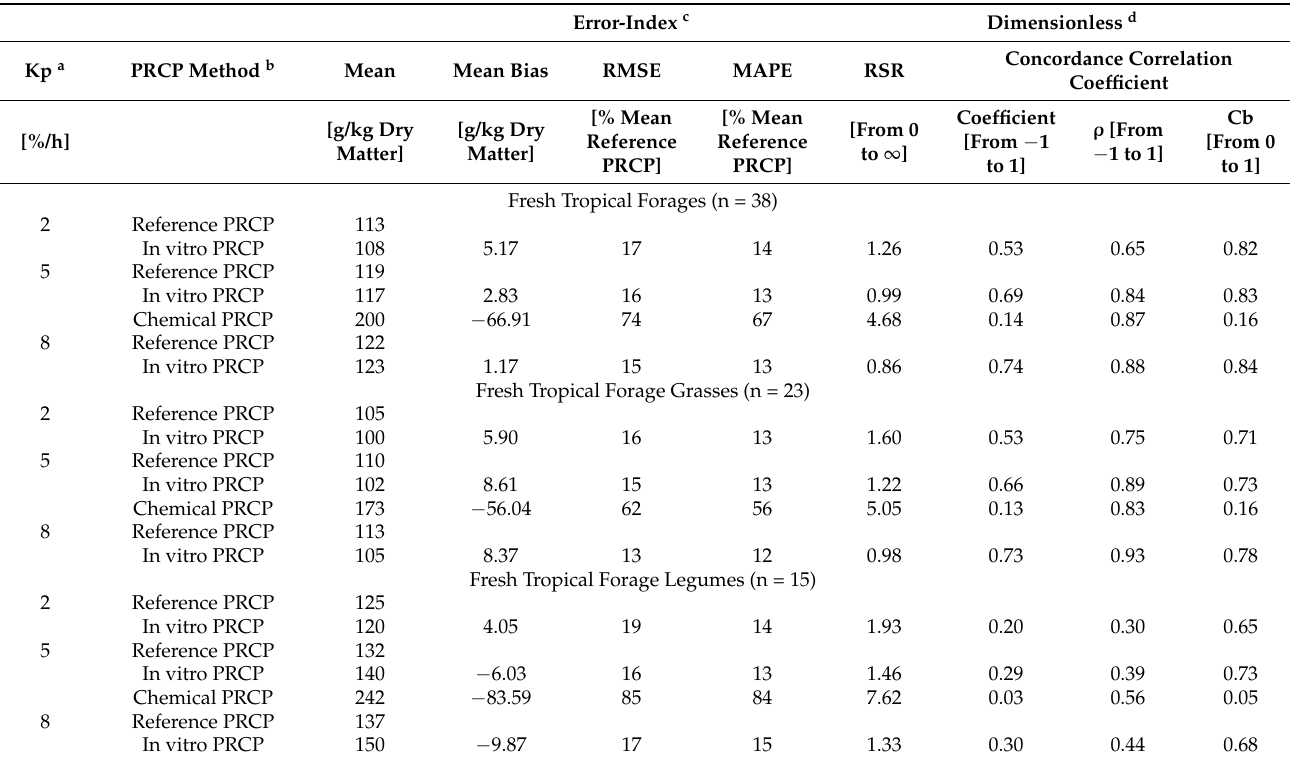
Table 2. Predictions of the post-ruminal crude protein (PRCP) supply as estimated with the reference and in vitro methods at rumen passage rates of 2, 5, and 8%/h and as calculated with the chemical method using the equation of Zhao and Cao [5] at rumen passage rate of 5%/h of fresh tropical forage grasses and legumes. Error-Index c Dimensionless d Kp a PRCP Method b